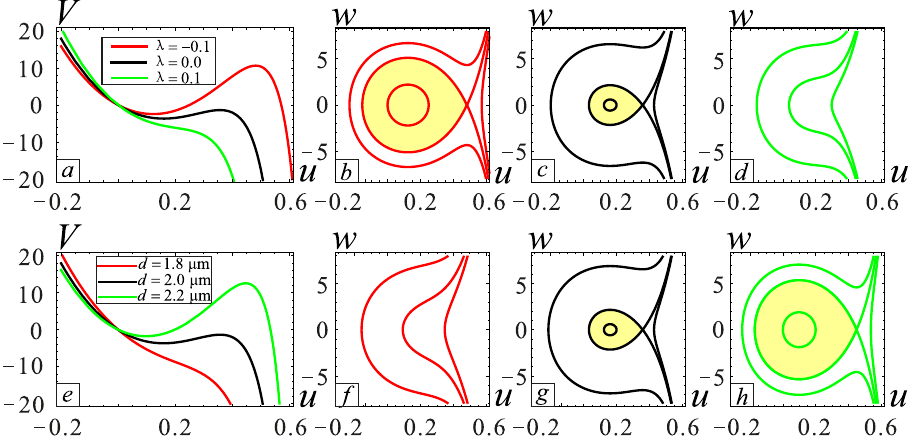
Figure 4. Potential energy curves and the corresponding phase diagrams under different physical parameters. ( a ) The potential energy curve under different section parameters with d = 2.0 μ m; ( b - d ) are phase diagrams of λ = –0.1, λ = 0 and λ = 0.1, respectively; ( e ) the potential energy curve under different gap distances with λ = 0. ( f – h ) are the phase diagrams of d = 1.8 μ m, d = 2.0 μ m and d = 2.2 μ m, respectively.